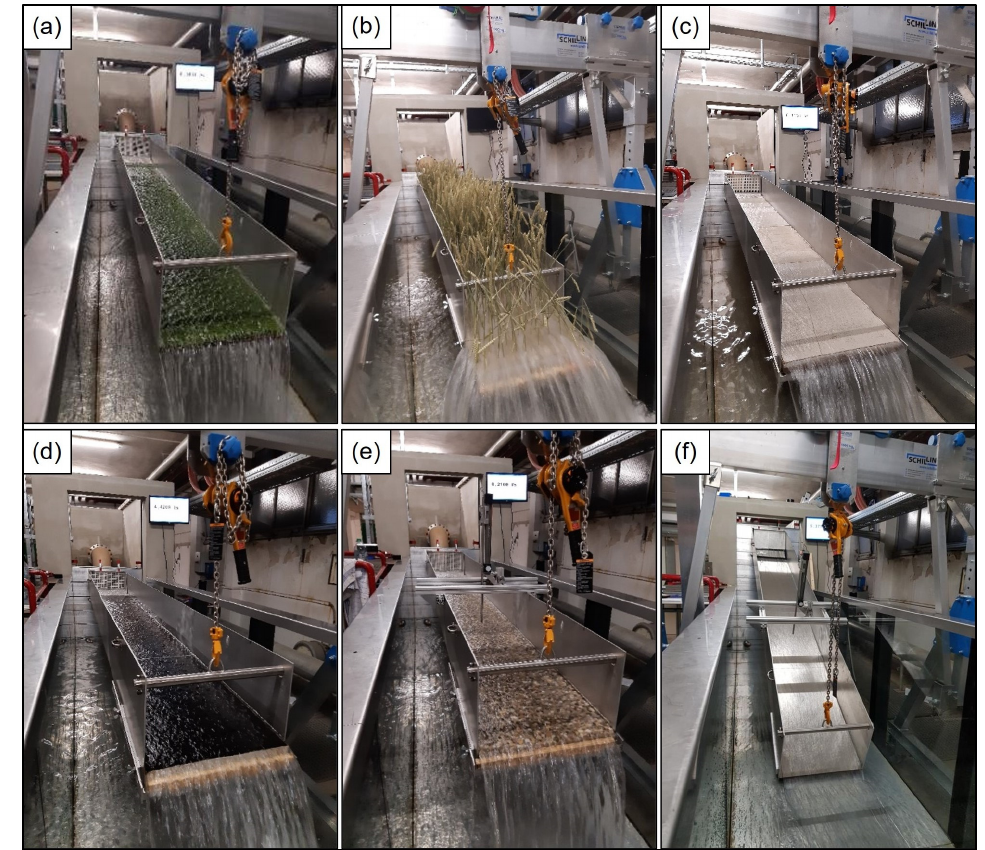
Figure 2. Photos of the experimental flume with different surfaces: ( a ) artificial grass, ( b ) wheat, ( c ) cement-based coating, ( d ) asphaltic emulsion, ( e ) exposed aggregate concrete, and ( f ) aluminum.